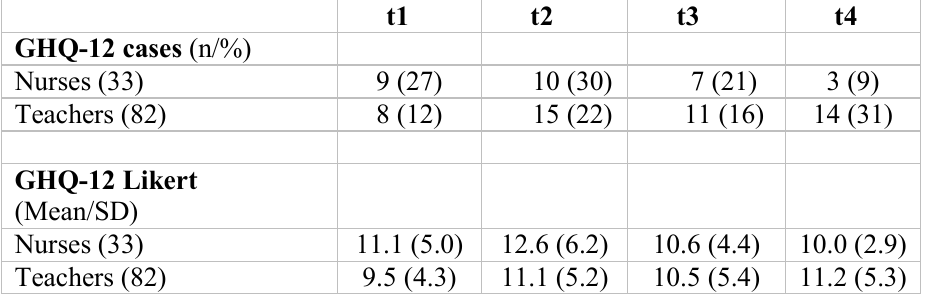
Longitudinal descriptive data about psychological distress at each of the four time points for the 115 completers t1 t2 t3